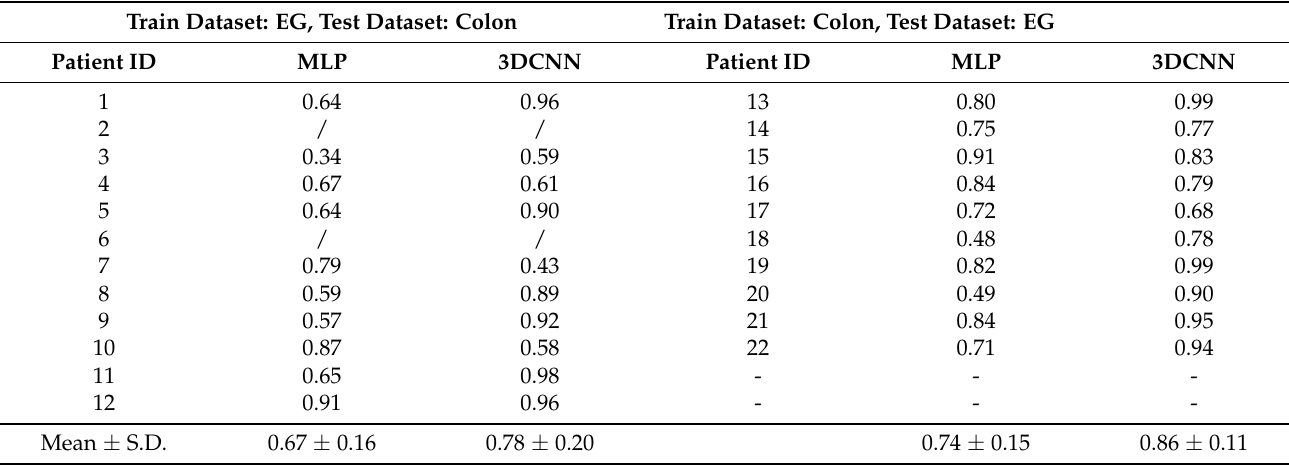
Table 5. ROC-AUC performance of the MLP and 3DCNN models with dataset cross-training. Train Dataset: EG, Test Dataset: